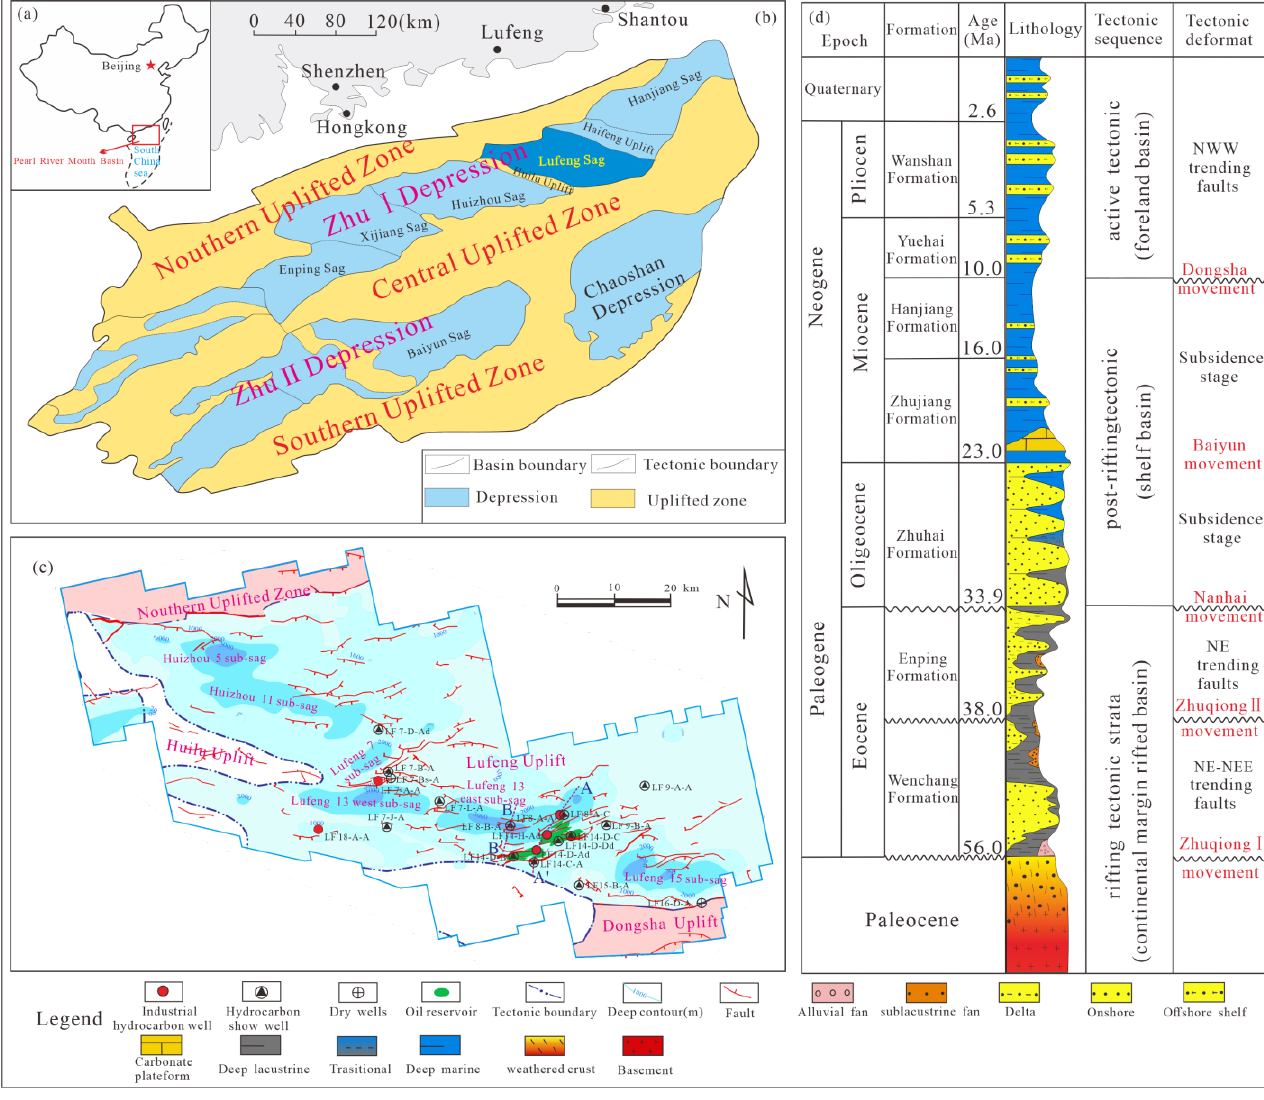
Figure 1. ( a ) Map of the Pearl River Mouth Basin in China; ( b ) the division of tectonic units in the Pearl River Mouth Basin and the location of the Lufeng sag; ( c ) the division of sub-tectonic units and well location of the WC in Lufeng sag (A-A’ shows the location of the geological section line; B-B’ shows the location of the seismic profile line); ( d ) formation, lithology, and tectonic of the Lufeng sag.